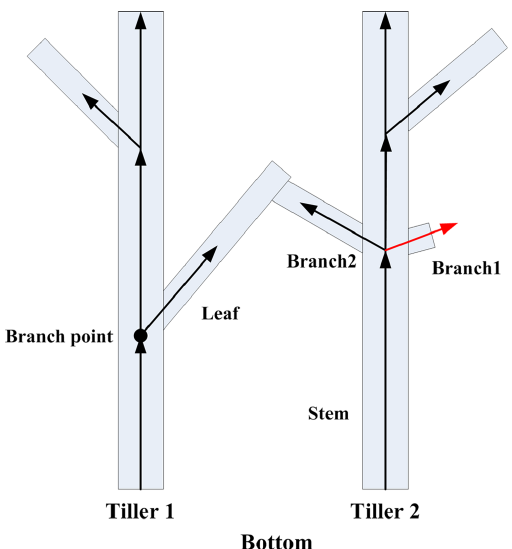
Fig. 5. De¯nitions of terms used in the tiller extraction and tiller angle calculation algorithms. A branch point is a voxel on a stem that has more than one connected voxel. N is a pa- rameter used to eliminate false branches (e.g., branch 1 on tiller 2) in the model resulting from reconstruction. Additionally, N was used to avoid connected search errors caused by leaf con- tact between tillers. Usually, N was set to 20 for a voxel size of 1 mm.